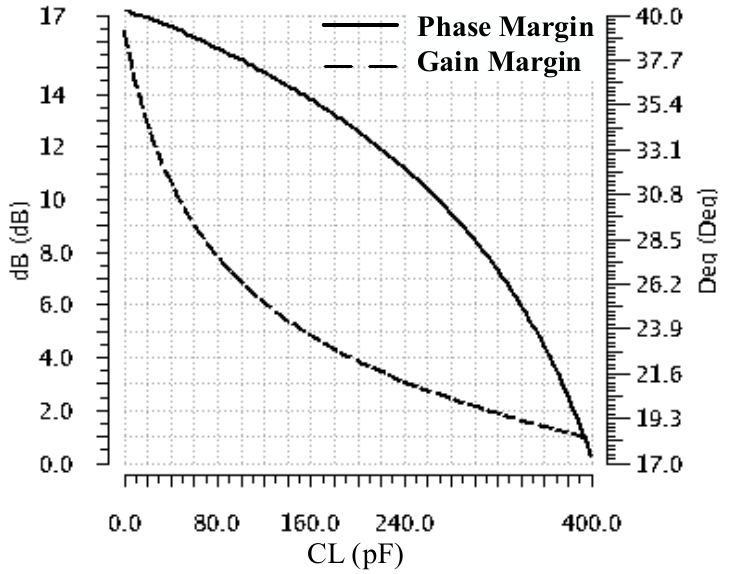
Figure 7. The phase and gain margin variation with CL ranging from zero to 400 pF at IL = 0 A. To make sure the LDO is stable one has to check that the circuit meets the requirements set by (1) for all operating conditions. This means verifying the phase and gain margins for each of the three loop gains depicted in Figure 4— T INNER , T CORE , and T LDO —when CL and IL are swept over their entire range of values—CL = 0 to 400 pF, IL = 0 to 100 mA—as shown in Figure 8. One notices that each loop exhibits a suitable phase margin for all CL and IL values: PM T > 60 ◦ , PM T > 20 ◦ , and PM T > 15 ◦ . INNER CORE LDO